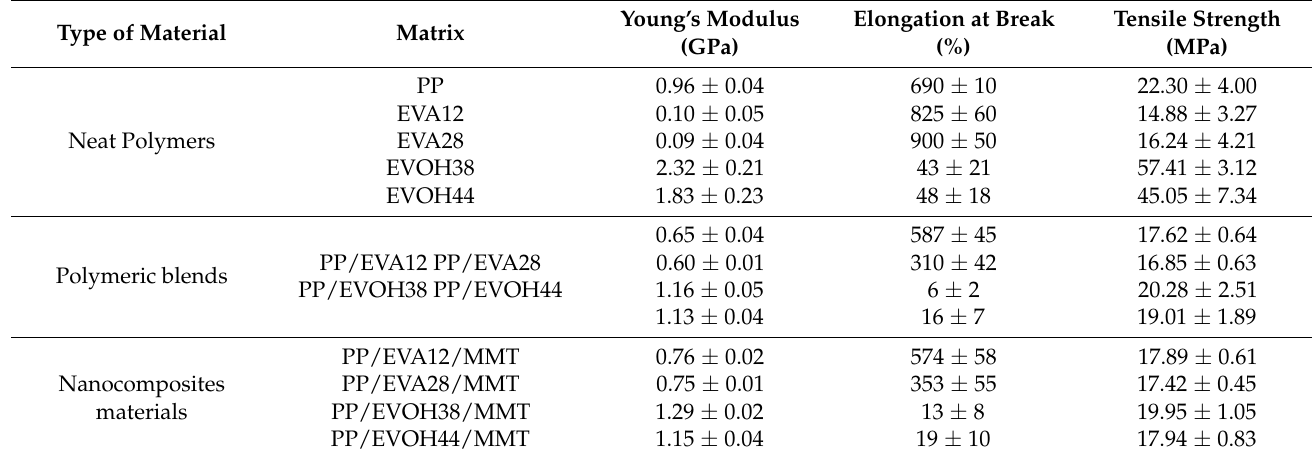
Table 3. Mechanical properties (Young’s modulus, elongation at break and tensile strength) of polymeric blends and nanocomposites